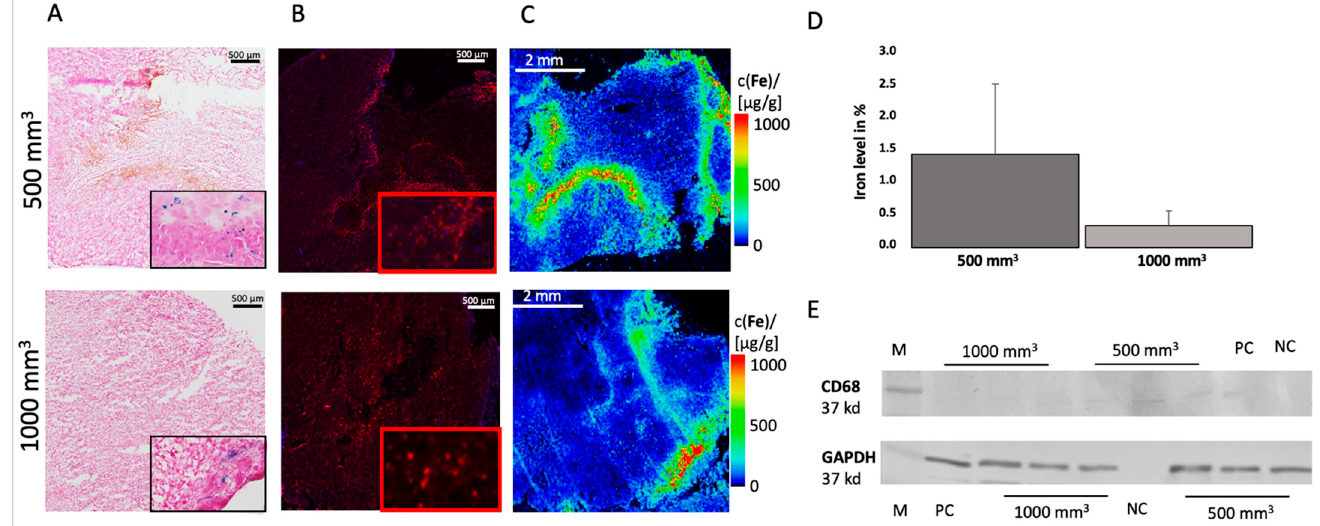
Figure 3. Ex vivo analysis of iron and CD68 in 500 mm 3 and 1000 mm 3 tumors. Top: 500 mm 3 . Bottom: 1000 mm 3 . ( A ) shows a Perls´ Prussian blue stain from 500 mm 3 tumor (top) and 1000 mm 3 (bottom). Blue colored areas indicate iron particle. ( B ) shows immunofluorescence staining of CD68. Counterstaining was performed with DAPI. ( C ) LA-ICP MS was performed to localize iron particles. ( D ) The percentage of iron in the histological Perls´ Prussian stain was determined. Three areas per slide were calculated and graphically displayed. Per group, n = 14 animals were analyzed. ( E ) A Western blot was performed for n = 3 tumors per group to detect the expression of CD68, 500 mm 3 mean value of 703.7 and 1000 mm 3 mean value of 304.8. A CD38 antibody was used, and GAPDAH was included as a control. M = marker, NC = negative control, PC = positive control. All the whole western blot figures can be found in the Figure S1.